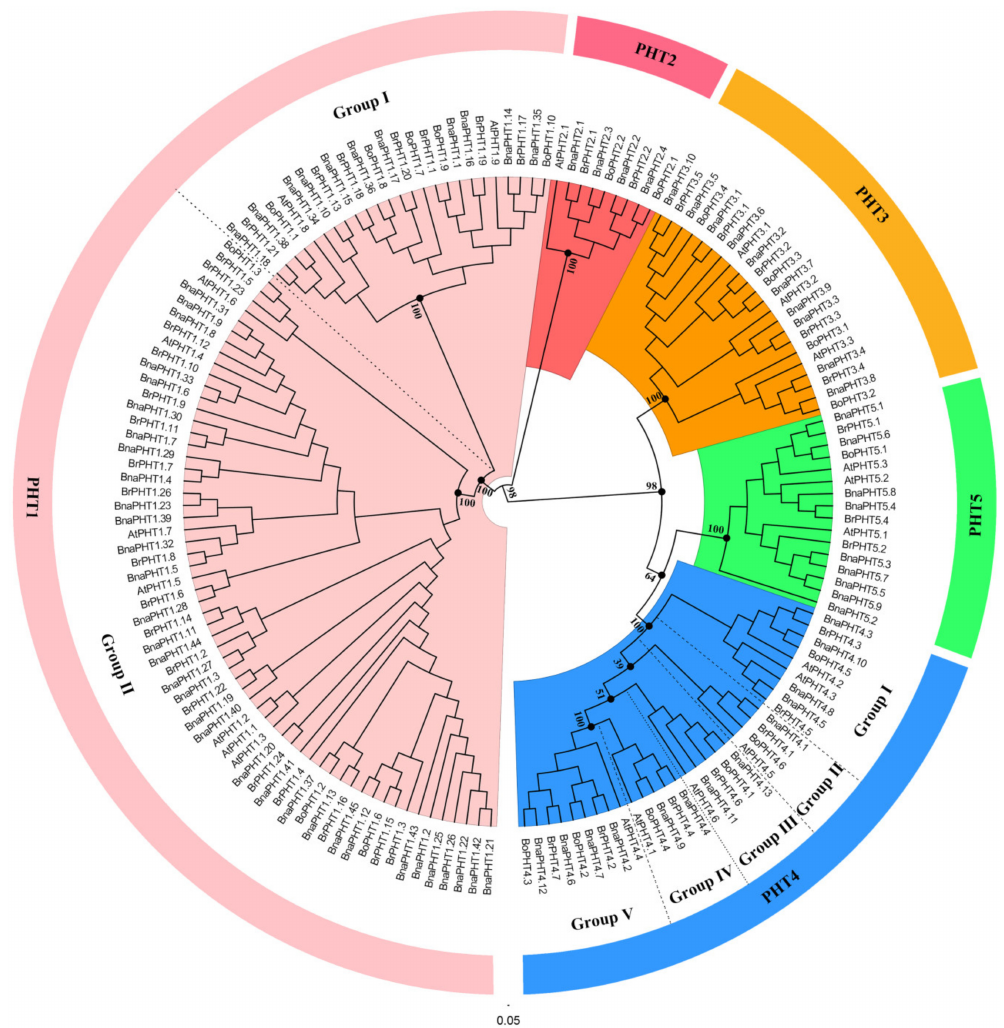
Figure 1. Phylogenetic analysis of phosphate transporter (PHT) gene families in Brassica napus , Arabidopsis , Brassica rapa and Brassica oleracea . The colored background indicates di ff erent PHT family. The di ff erent groups within the PHT1 and 4 families were separated by dashed lines,